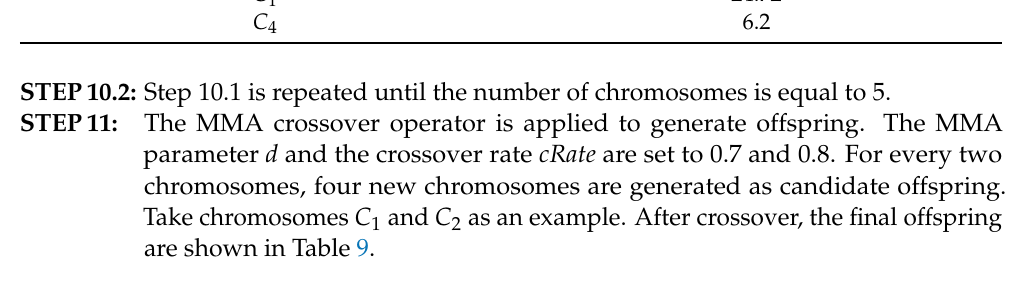
Table 9. Four new generated